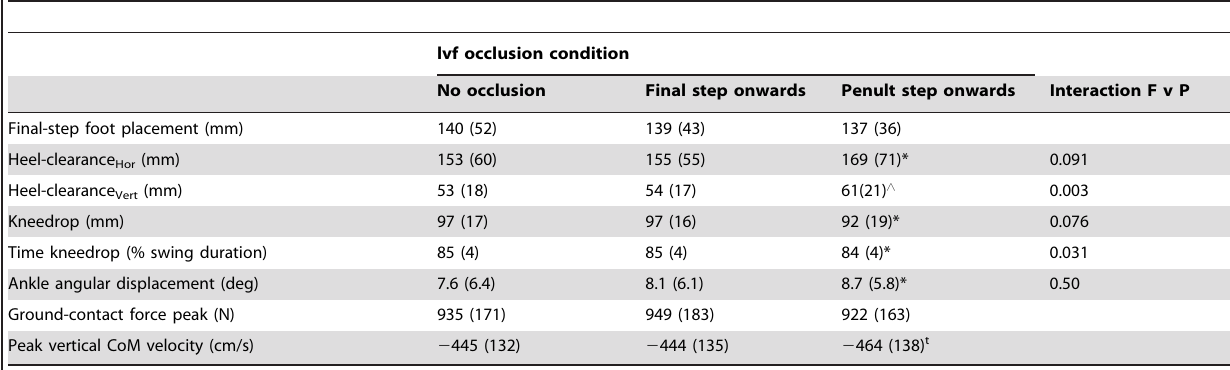
Table 1. Group mean ( 6 1 SD) kinematic measures for the full vision and lvf occlusion conditions: a) measure occurring during approach, b) measures occurring during the step on to floor, and c) measures occurring during